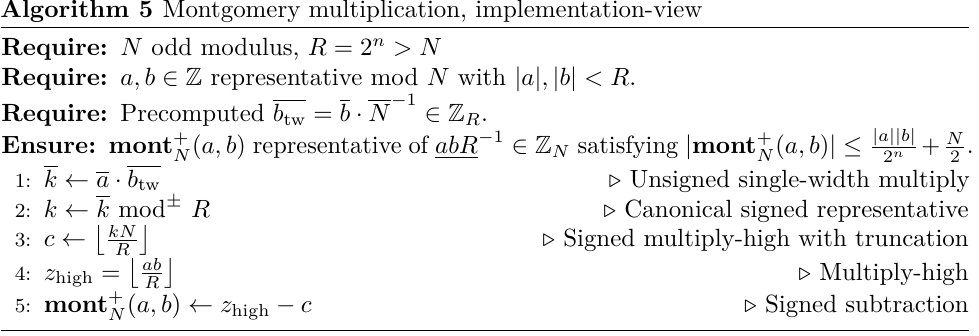
Algorithm 5 Montgomery multiplication,